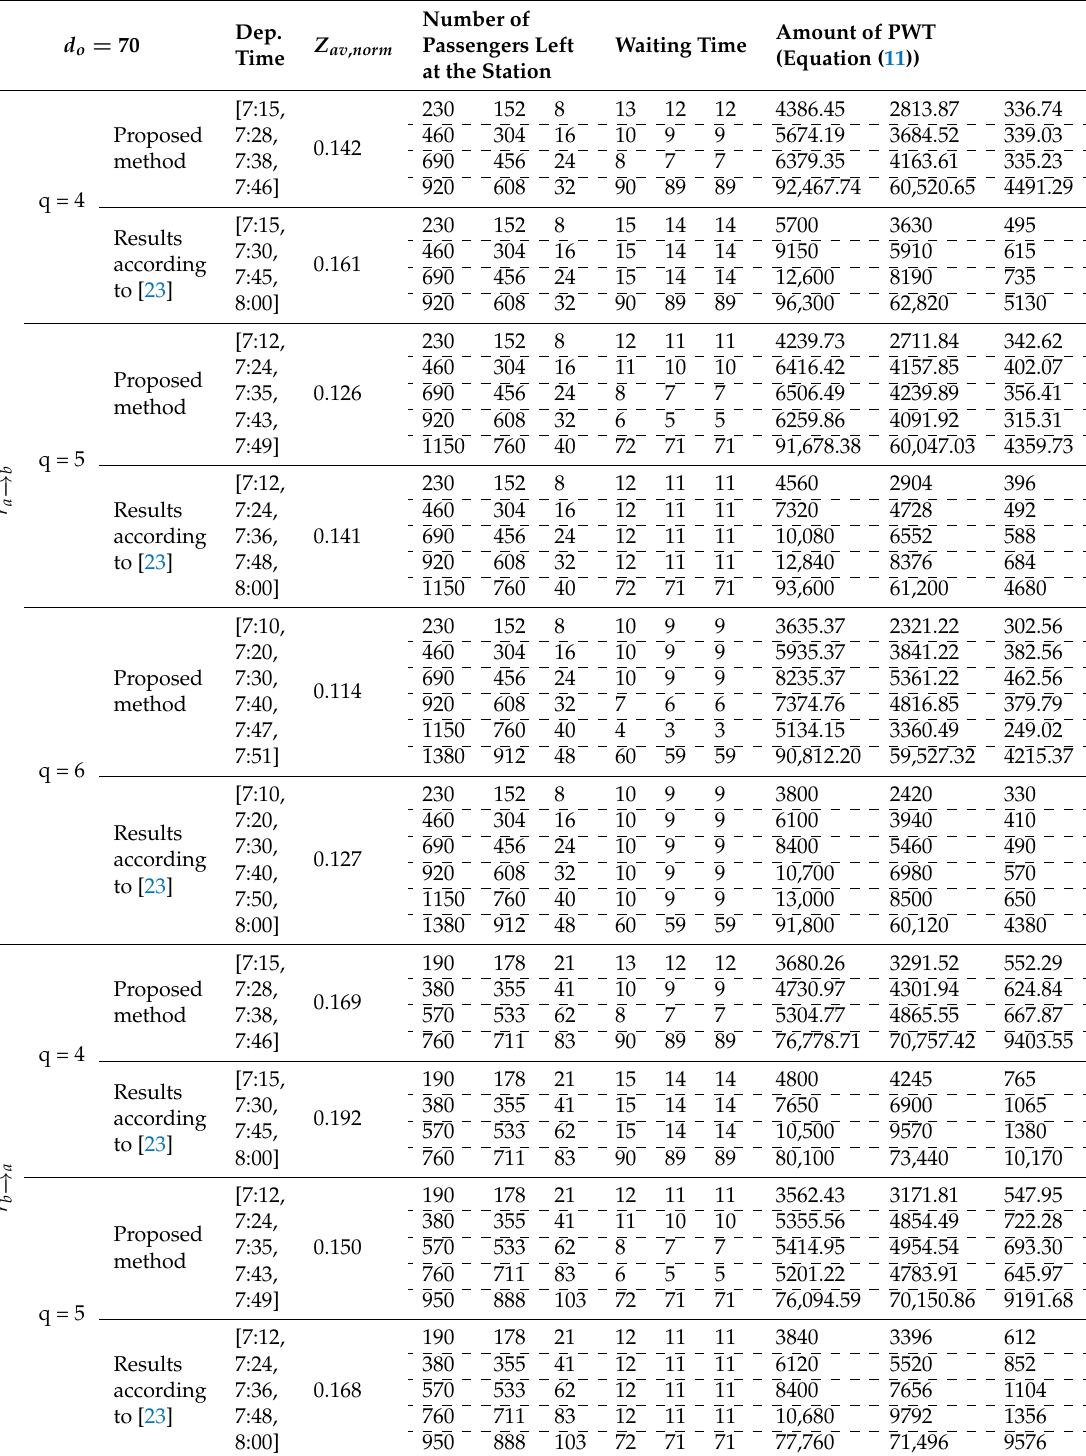
Table 4. Comparison of the results obtained in Experiment 1 using the proposed method and those obtained in the literature